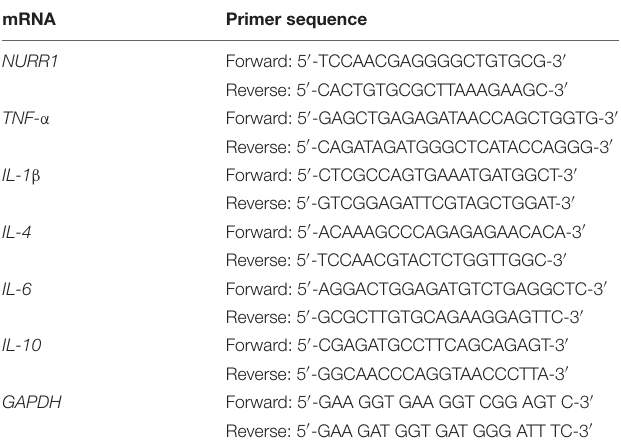
TABLE 2 | List of primers used for quantitative real-time PCR